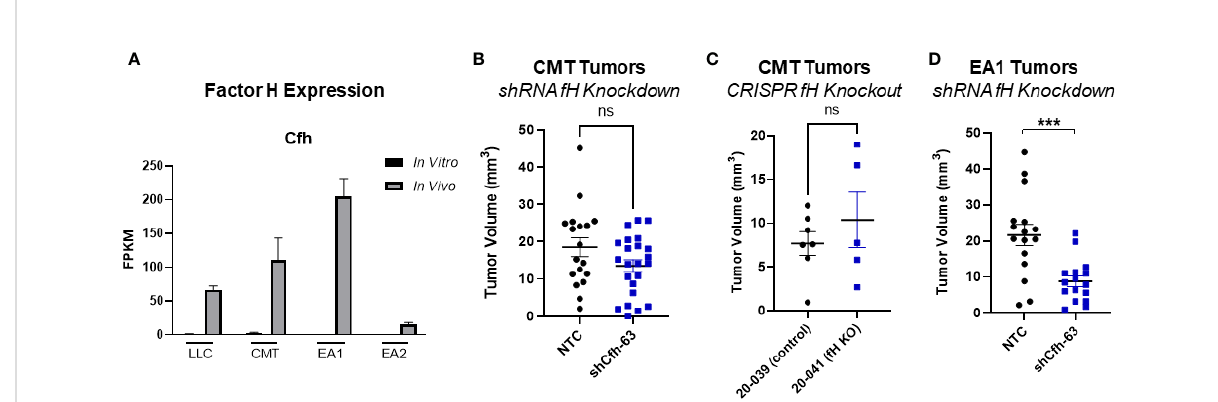
FIGURE 6 Effect of factor H on tumor progression. (A) Factor H (Cfh) RNA Expression in vivo vs in vitro from the RNAseq data, expressed as FPKM values. In all 4 cell lines, the in vivo samples appear to induce expression compared to the in vitro cells. (B) 500K CMT cells stably transfected with factor H shRNA (shCfh-63) or control cells (NTC) were implanted into the left lung of C57Bl/6 mice, established for 2 weeks, were harvested and tumors measured. Results are the combination of 3 independent experiments where n=5-10/group/experiment. (C) 500K CMT cells with fH deleted using CRISPR (20-041) or control cells (20-039) were implanted into the left lungs of C57Bl/6 mice, established for 2.5 weeks, and tumor volume was measured using digital calipers. N=5 or 7 per group. (D) 250K EA1 cells stably transfected with factor H shRNA (shCfh-63) or control cells (NTC) were implanted into the left lung of C57Bl/6 mice, established for 2.5 weeks, were harvested and tumors measured. Results are the combination of 2 independent experiments where n=6-10/group/experiment. 1 outlier was removed using the ROUT test where Q=1%. A nonparametric Mann-Whitney test was performed on all experiments; ns, not signi fi cant; ***p<0.0001.